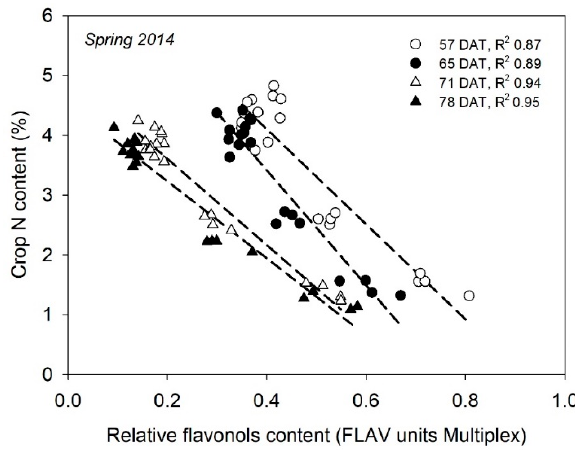
Figure 6. Linear relationships of leaf relative flavonols content (FLAV units of the MULTIPLEX sensor) to crop N content from a greenhouse-grown cucumber crop in Spring 2014 carried out in southeast Spain. DAT is days after transplanting and R 2 is the coefficient of the determination of linear regression.